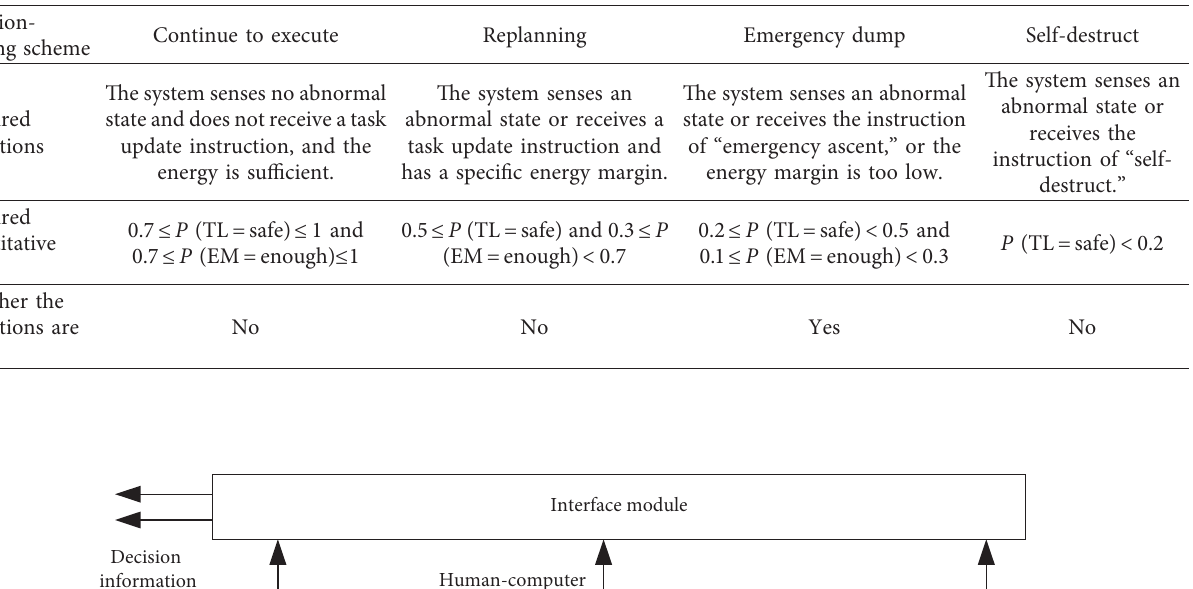
Table 8: Trigger conditions of decision-making schemes.